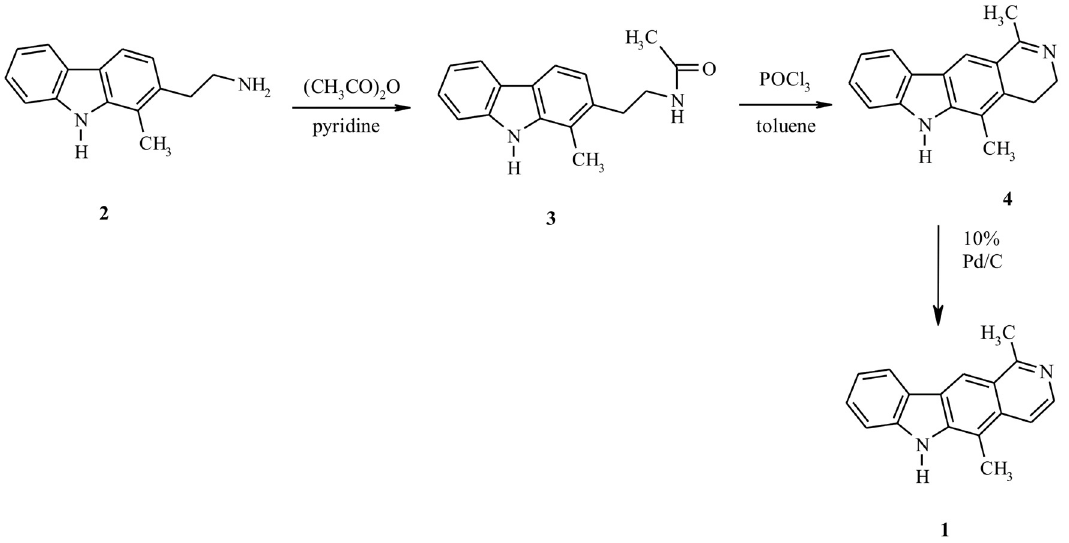
Figure 1. Synthesis of olivacine.